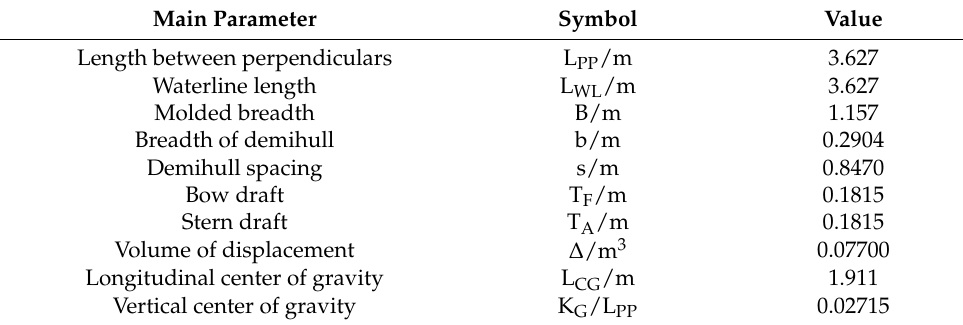
Table 1. The main parameter of the Delft catamaran.